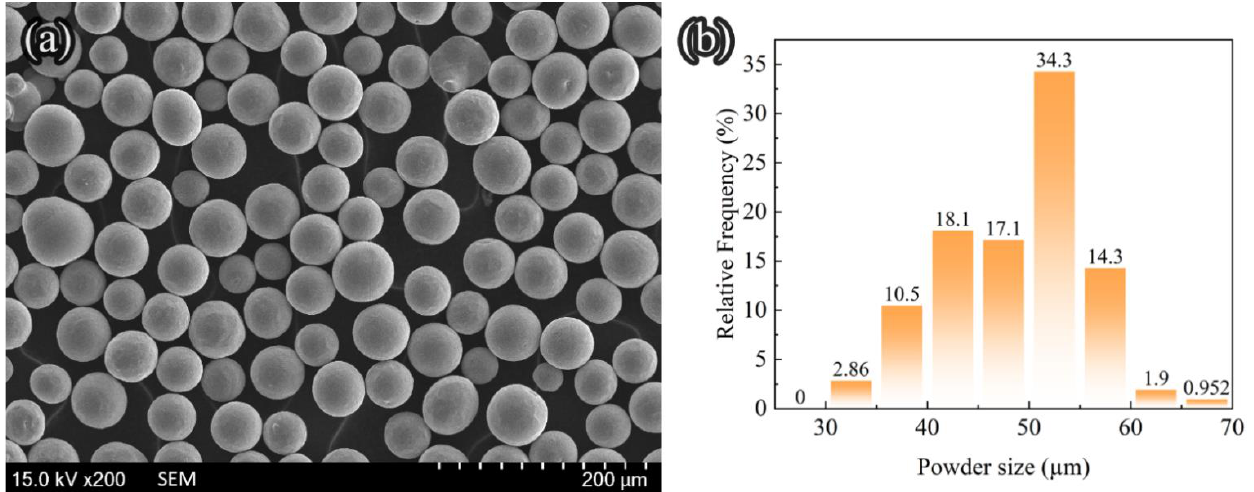
Figure 1. ( a ) The initial TC4 powders; ( b ) the size distribution of the powder.